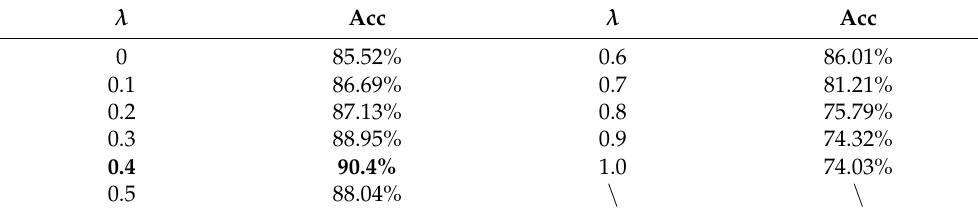
Table 3. Performance evaluation of face verification with different λ on the Pandora